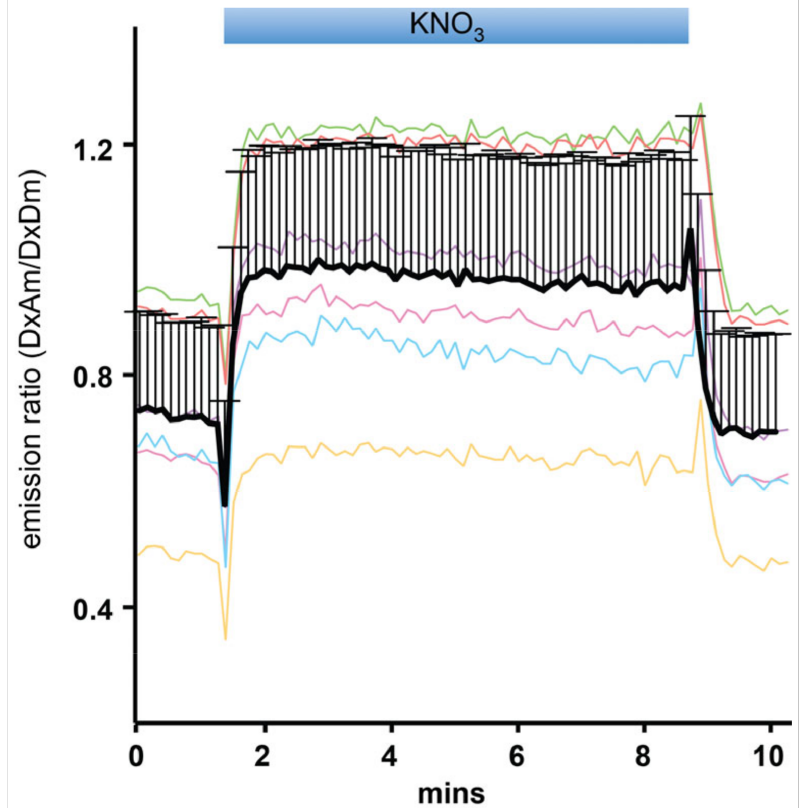
Figure 4. Analysis of the NiTrac-NPF1.3 response in individual yeast cells trapped in a Cellasic microfluidic plate. Cells were initially perfused with 50 mM of MES buffer at pH 5.5, followed by a square pulse of 5 mM of KNO 3 in MES buffer for about seven minutes (blue frame). Color lines: individual data of cells. Black line: normalized data from individual cells (mean ± SD; n = 6). Similar results were obtained in at least three independent